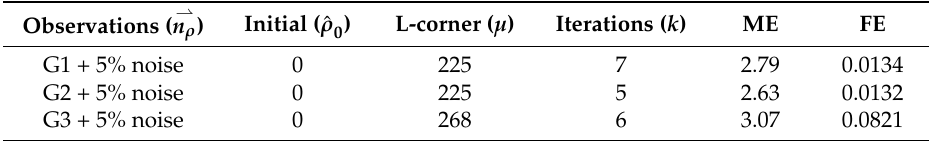
Table 1. Conditions and results for three different synthetic inversion